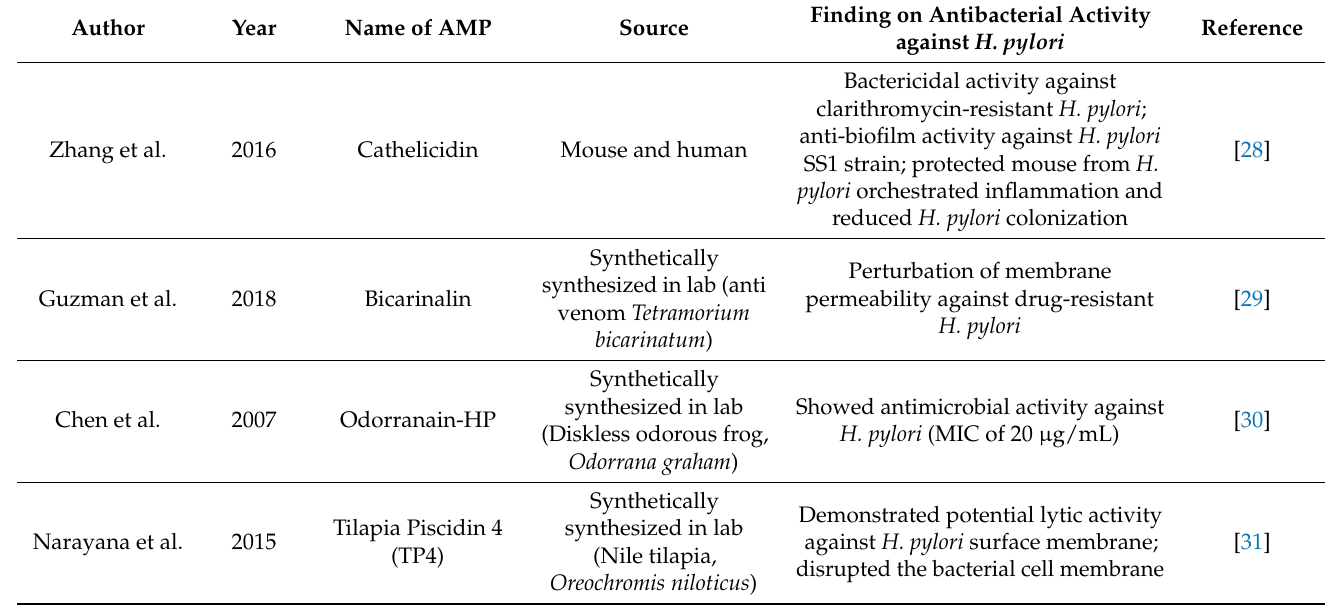
Table 3. Summary of studies conducted on antimicrobial peptides against H. pylori